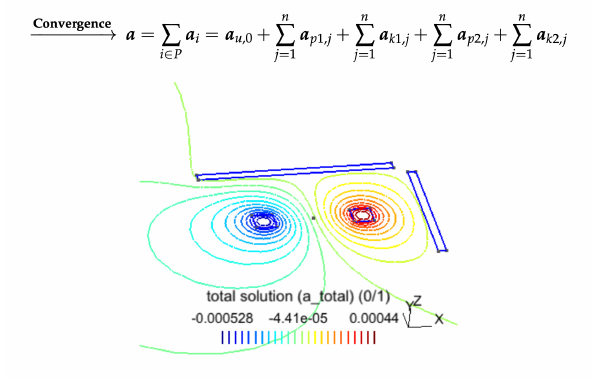
Fig. 4. Convergence solution of a of SPs at 12 iterations.